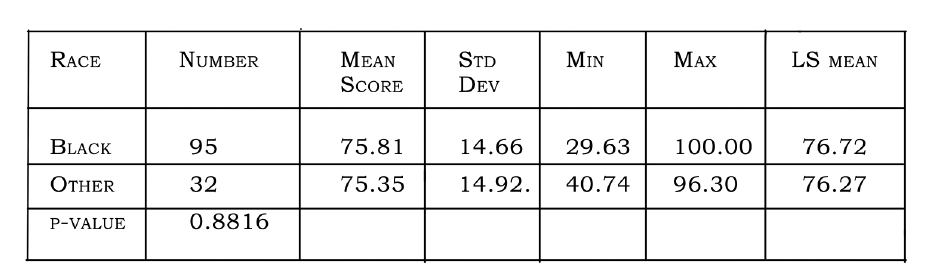
Table 4: Awareness percentage scores by race: All